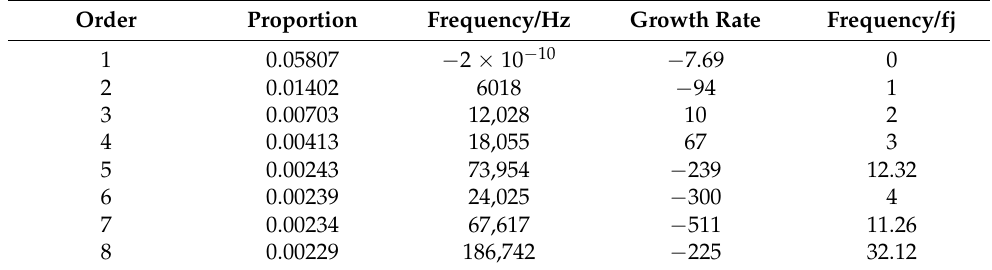
Table 8. Modes’ characters of the first eight modes in Case